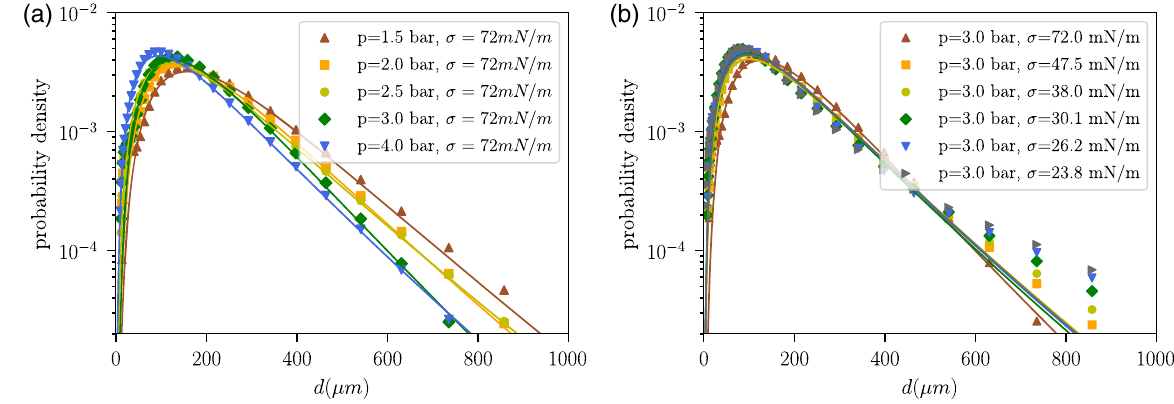
FIG. 2. (a) The droplet size distribution for pure water with pressures from 1.5 to 4.0 bar for the Teejet 110-03 nozzle (flat liquid sheet). Fit lines are of the global size distribution [Eq. (11)] with parameters m and n around 5. (b) Droplet size distributions of water-ethanol mixtures with different surface tensions (Teejet 110-03, flat liquid sheet). The fit parameters are similar to those for pure water. A deviation from the fit lines can be seen for large droplet sizes, with a systematic enhancement for increasing ethanol concentrations.